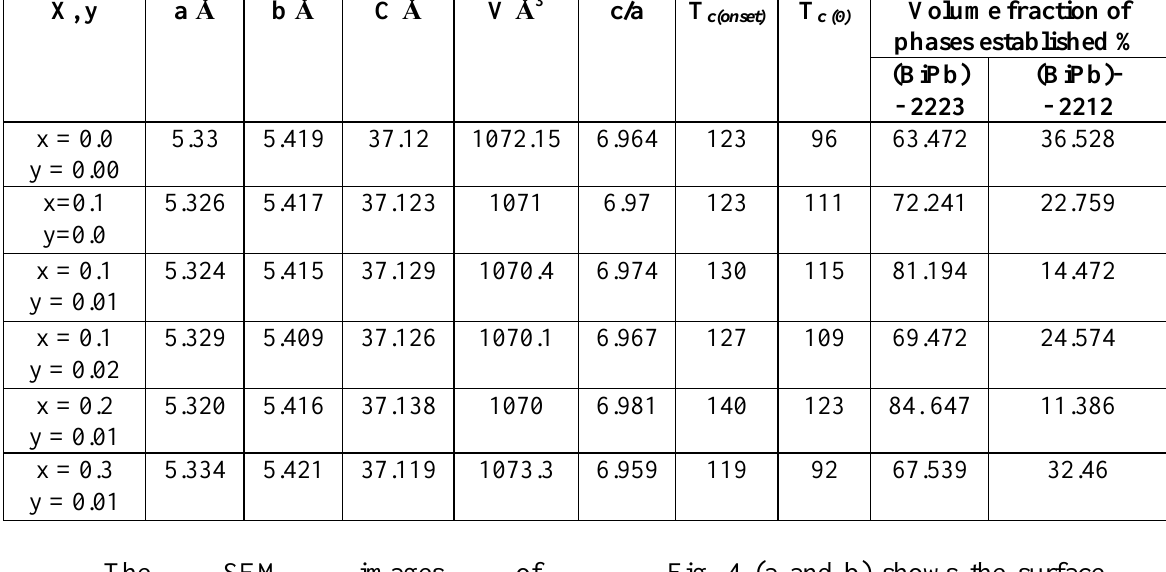
Sb Pb Sr Ca Cd Cu O superconductors 1.6-x x 0.4 2 2-y y 3 Z